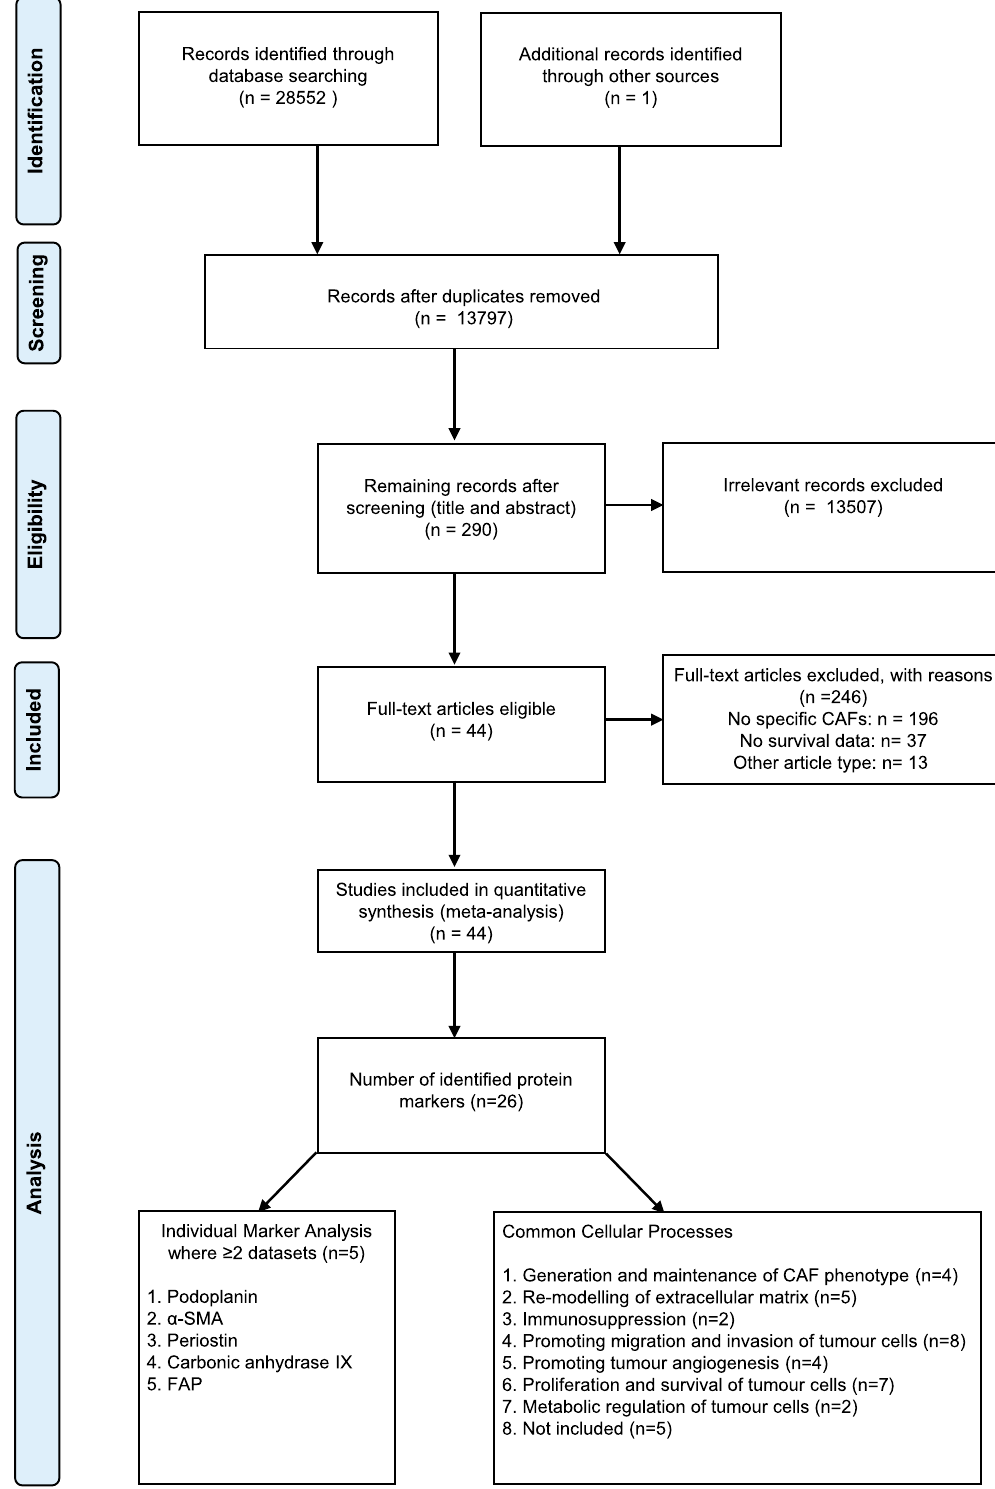
Figure 1. Flow chart describing steps carried out in selecting